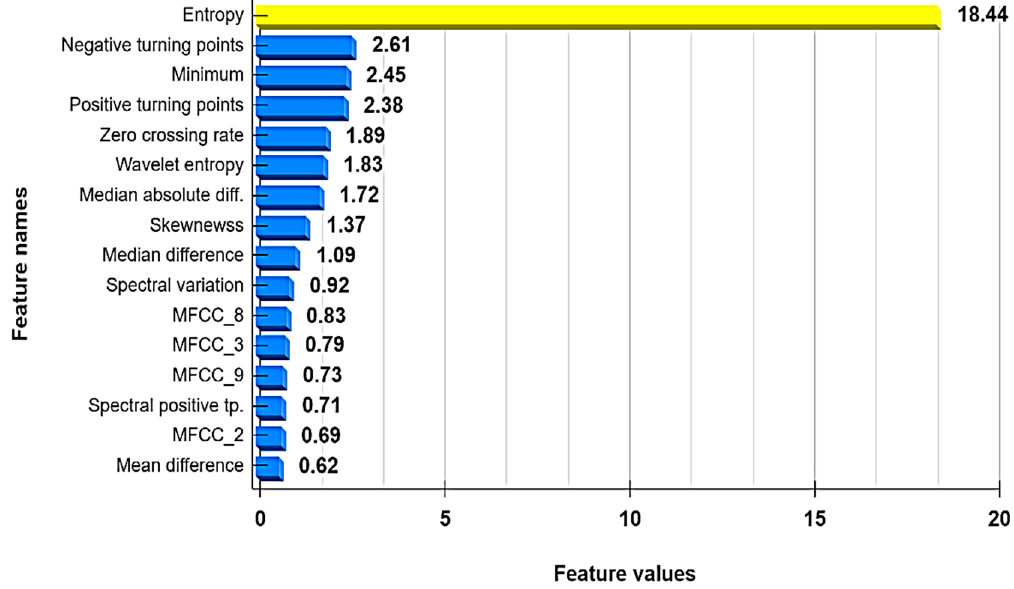
20 of 26 Figure 16. Confusion matrix of proposed theft-detection model.